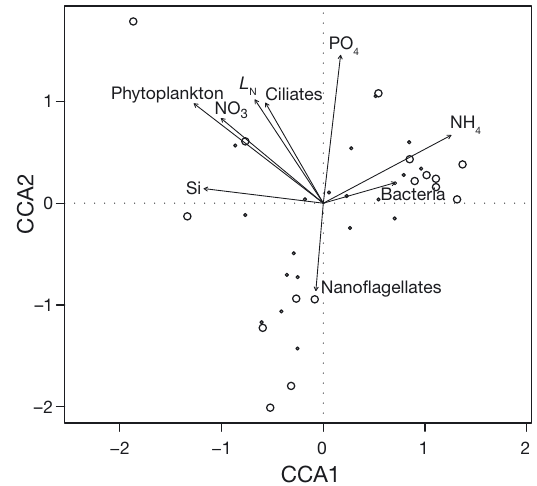
Fig. 6. Canonical correspondence analysis (CCA) of phyto- plankton counts at the genus level on Days 10 and 16 of the experiment. The genera are indicated by small circles and the samples by bigger circles. Of the mean squared contin- gency coefficient (variance), 85% was constrained by the components, i.e. by the environmental variables. The pro- portion of the variance explained by the first 2 components was 61%, and of the constrained part of the variance, the 2 first axes covered 72%. The permutation test for CCA indi- cated significance of the constraints on microbial community structure when all constraints (environmental variables) were included (p = 0.005). When testing for individual envi- ronmental variables as constraints, PO 4 and bacterial, nano- flagellate, and ciliate abundance were not significant. All other constraints were significant with p <